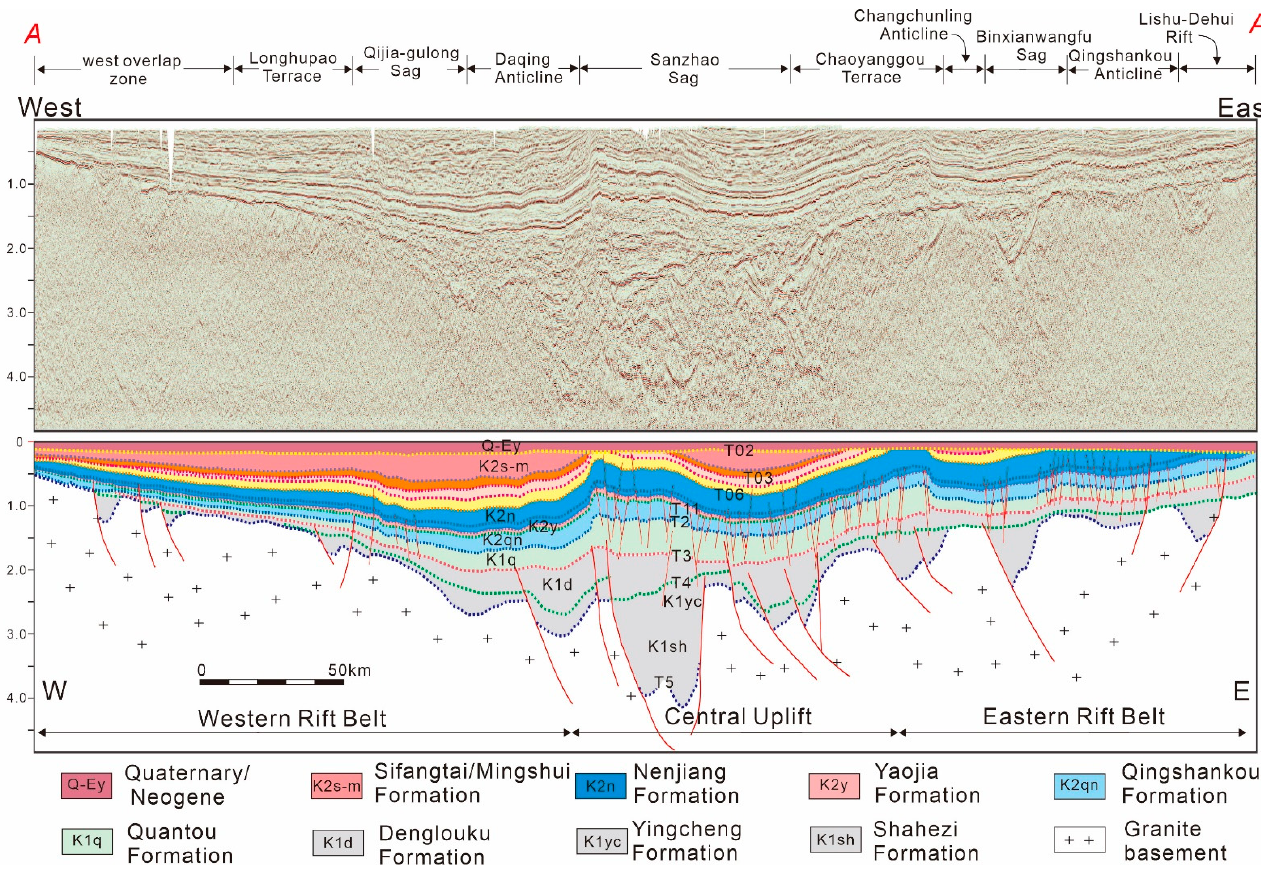
Figure 2. Regional seismic profile across the study area, showing the structural–stratigraphic characteristics of the basin; the section line (red line) is shown in Figure 1A (modified from Song et al. [54]).